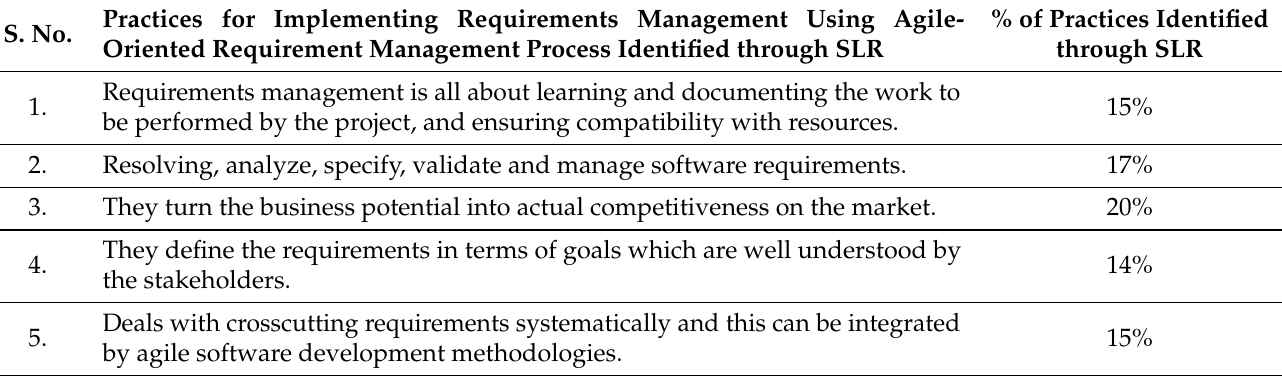
Table 23. Practices for implementing requirement management using agile-oriented requirement management process. Here, the threshold is